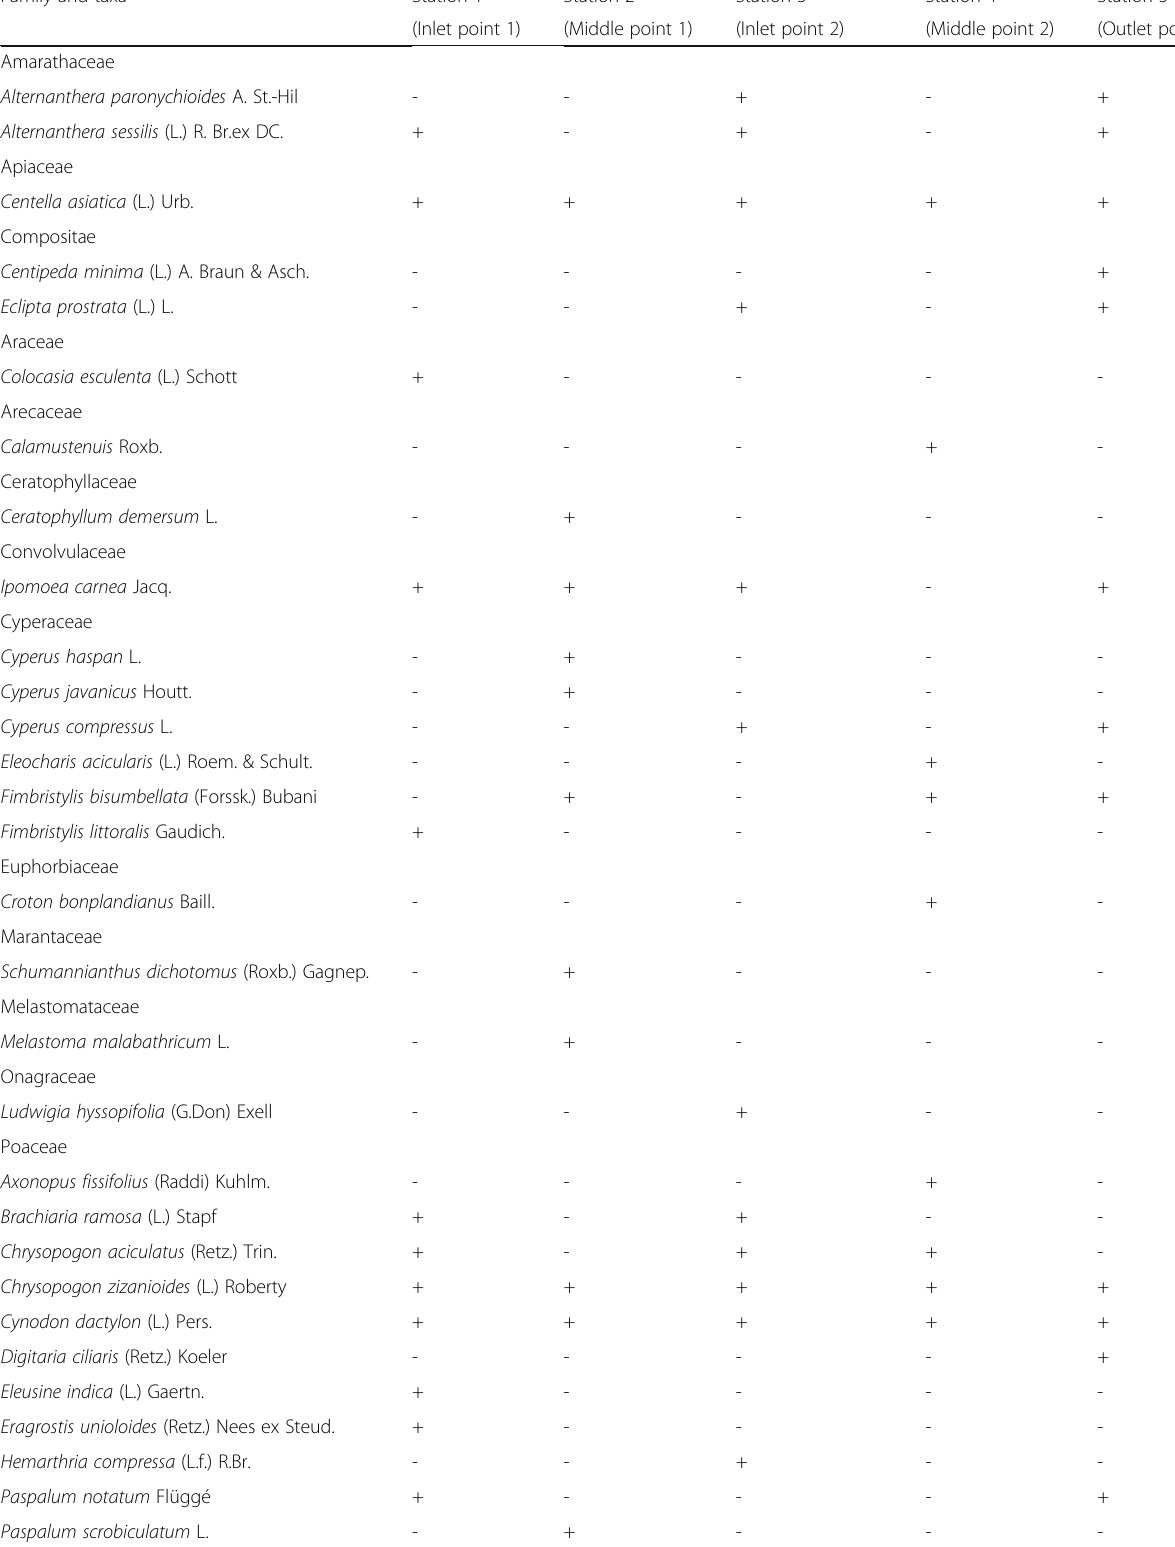
Table 1 Distribution and diversity profile of vegetation in the wetland across different sampling